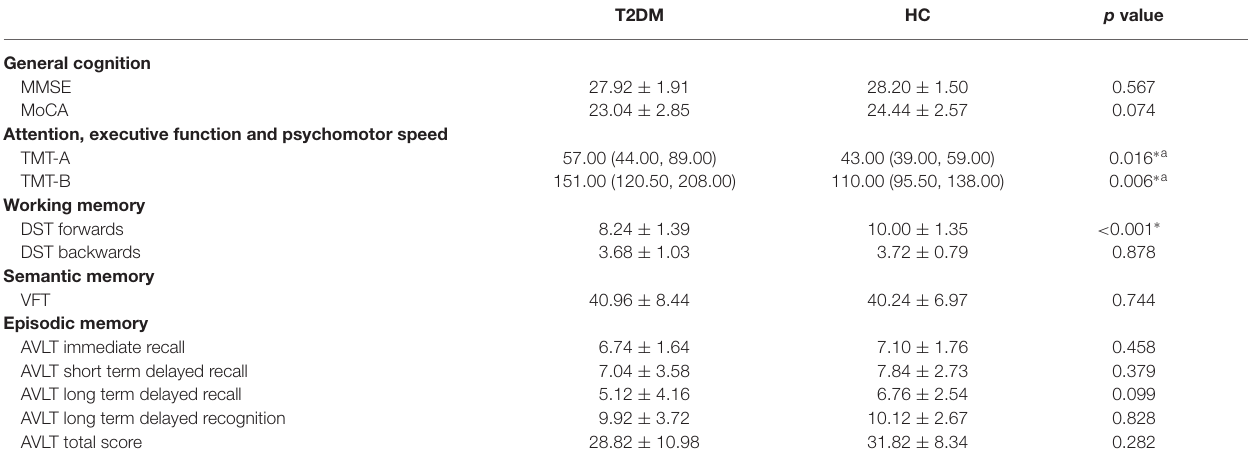
TABLE 2 | Comparison of neuropsychological test results of T2DM patients and healthy